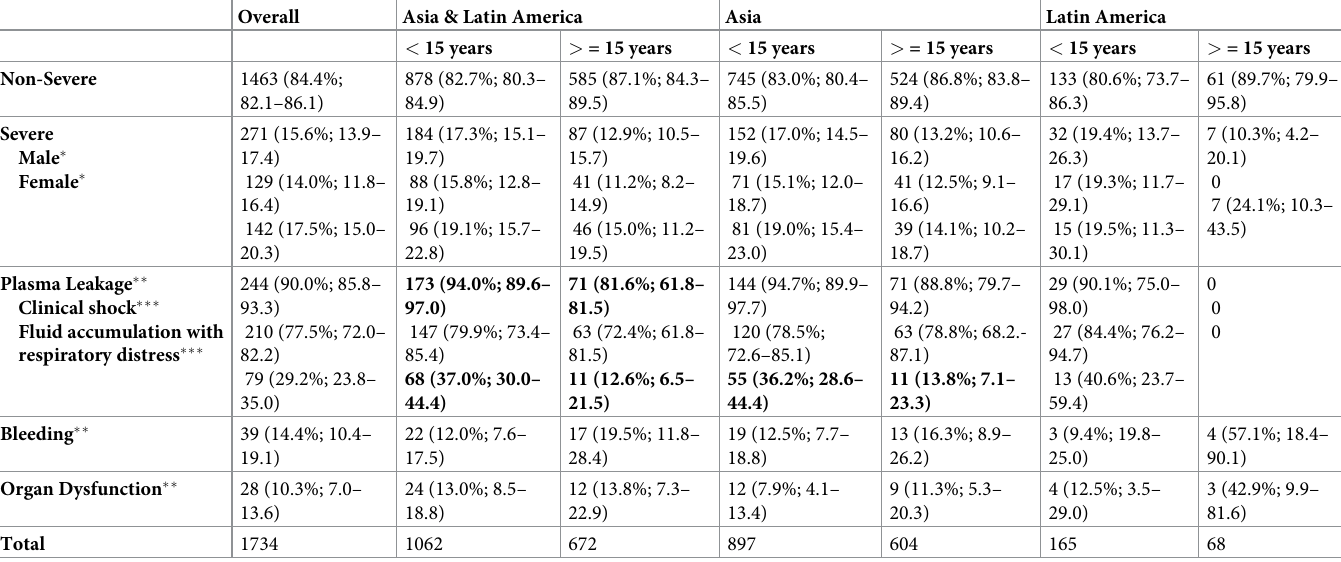
Table 3. Frequency of severe dengue categories comparing children ( < 15 years) versus adults and Asia versus Latin America. Overall Asia & Latin America Asia Latin America < 15 years > = 15 years < 15 years > = 15 years < 15 years > = 15